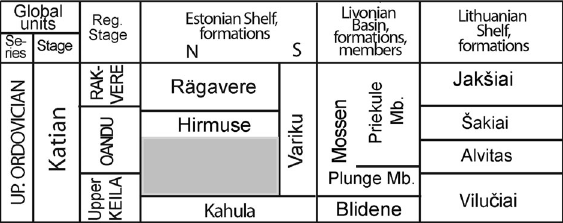
Fig. 1. Generalized correlation chart of the early Katian, formations and members (Mb.) of the East Baltic. Up. Ordovician, Upper Ordovician; Reg. Stage, Regional Stage; N, northern; S, southern part of the Estonian Shelf; the grey area marks the possible interval missing in the Keila–Oandu transitional interval of the shallow part of the Estonian